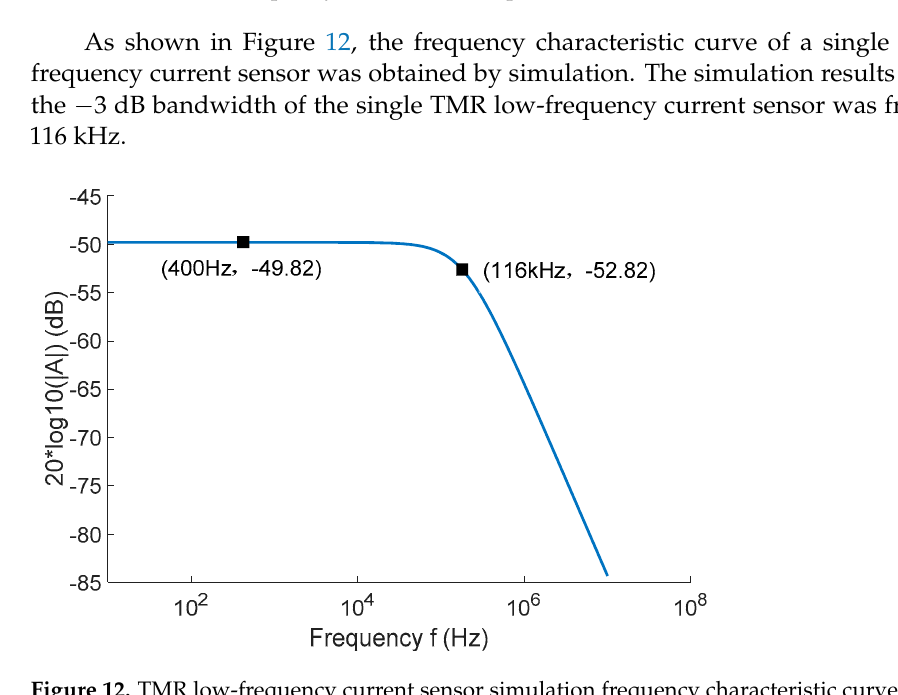
Figure 12. TMR low-frequency current sensor simulation frequency characteristic curve.